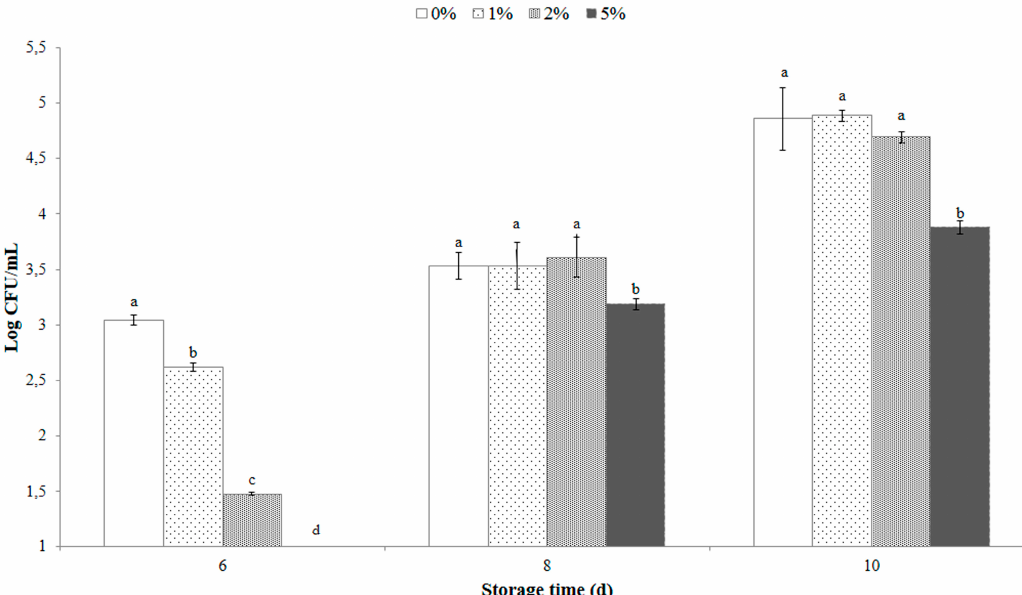
Figure 4. Total mesophilic bacterial (TMB) counts of milk samples added with di ff erent amounts of olive leaf extract (OLE), over 10 d of storage at refrigerated condition. Columns at the same storage time (6, 8, and 10 d) marked by di ff erent letters are significantly di ff erent according to Fisher’s least significant di ff erence test ( p < 0.05). Vertical bars indicate the standard deviation of the mean.